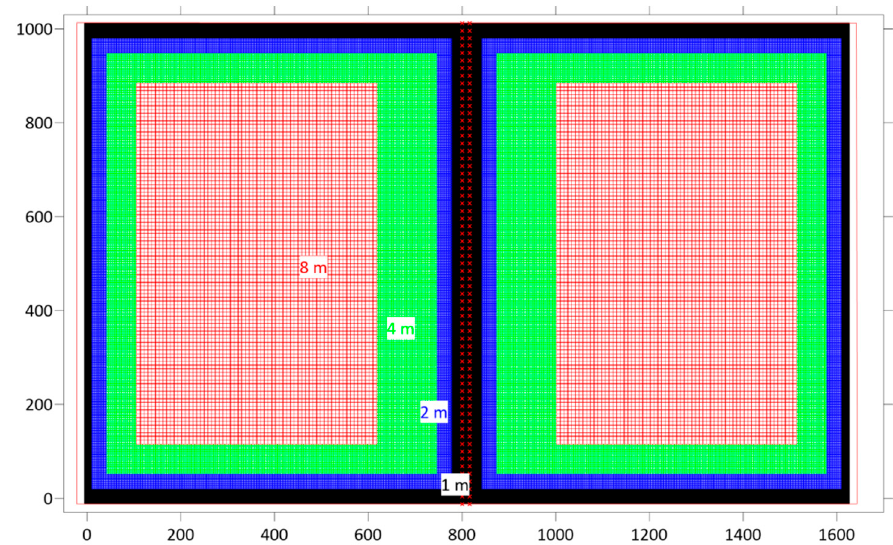
Figure 6. Multiresolution grid for the V-Shaped domain; 1 × 1 m cells in black, 2 × 2 m cells in blue, 4 × 4 m cells in green and 8 × 8 m cells in red. Table 1. Characteristics of simulations, compression rates C R and speed-up S U for the BUQ grid used in the V-shaped test case.